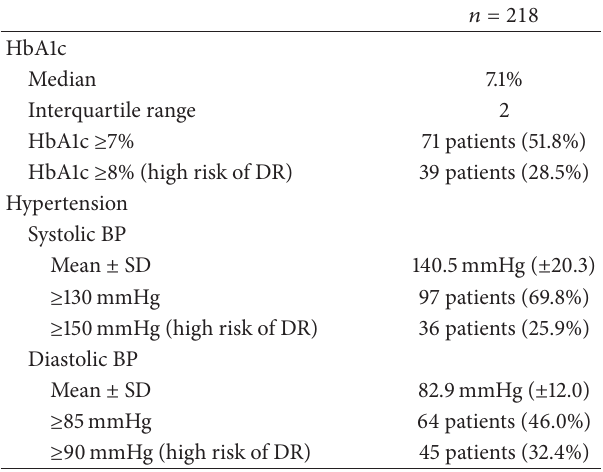
Table 3: Clinical characteristics based on total screening